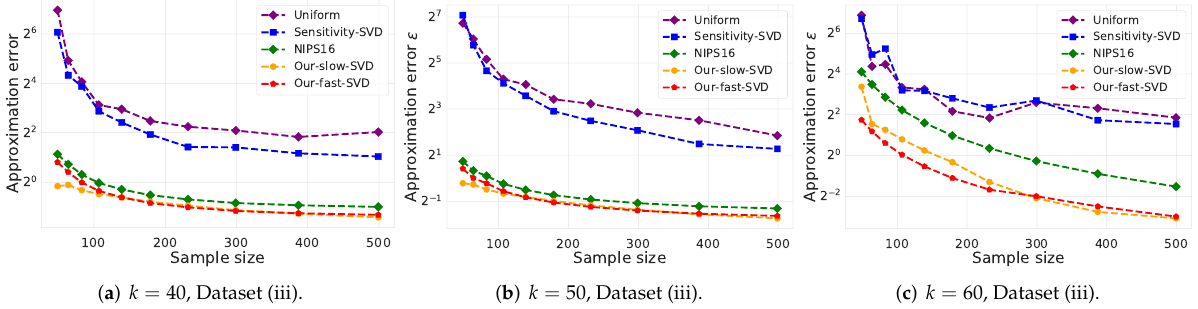
Figure 4. Experimental results for k -SVD, we used Dataset (iii). The x axis is the size of the subset (coreset), while the y axis is the approximation error ε . The difference between the 3 graphs is the chosen low dimension k